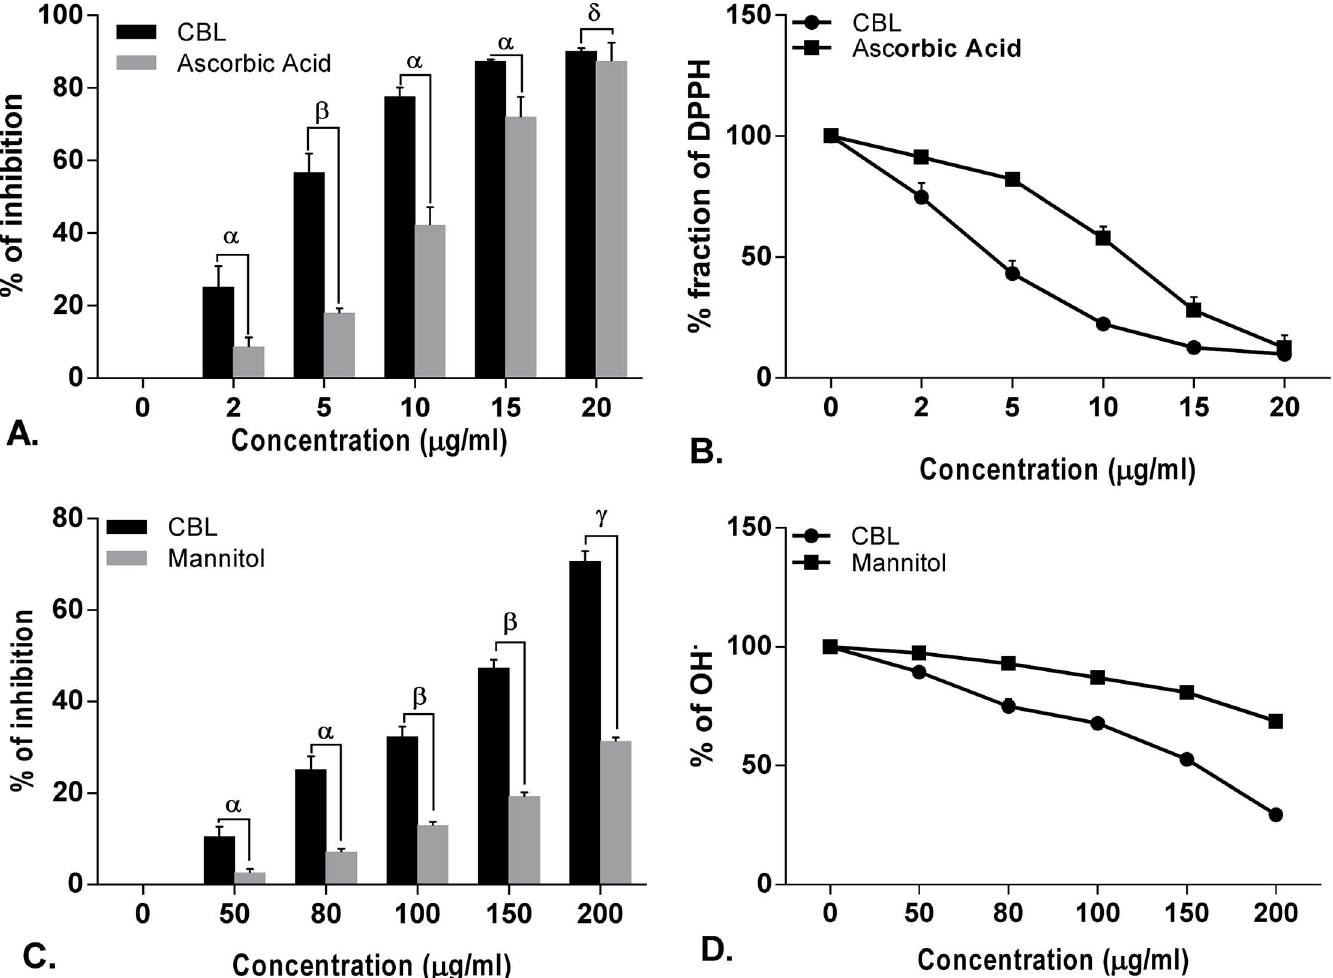
Fig 1. Antioxidant activity of Croton bonplandianus . (A) & (B) DPPH scavenging activity; (C) % of hydroxyl radical (OH • ) scavenging Vs standard mannitol; (D) depicts remaining unneutralized OH • . Data expressed as mean ± S.D (n = 6). α p < 0.05; β p < 0.01; γ p < 0.001; NS -Non significant when compared with standard.